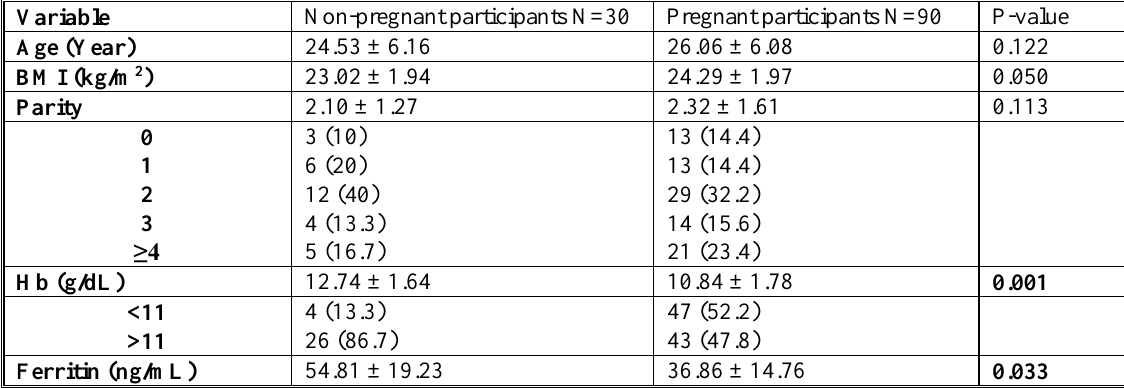
Table 1. Participants’